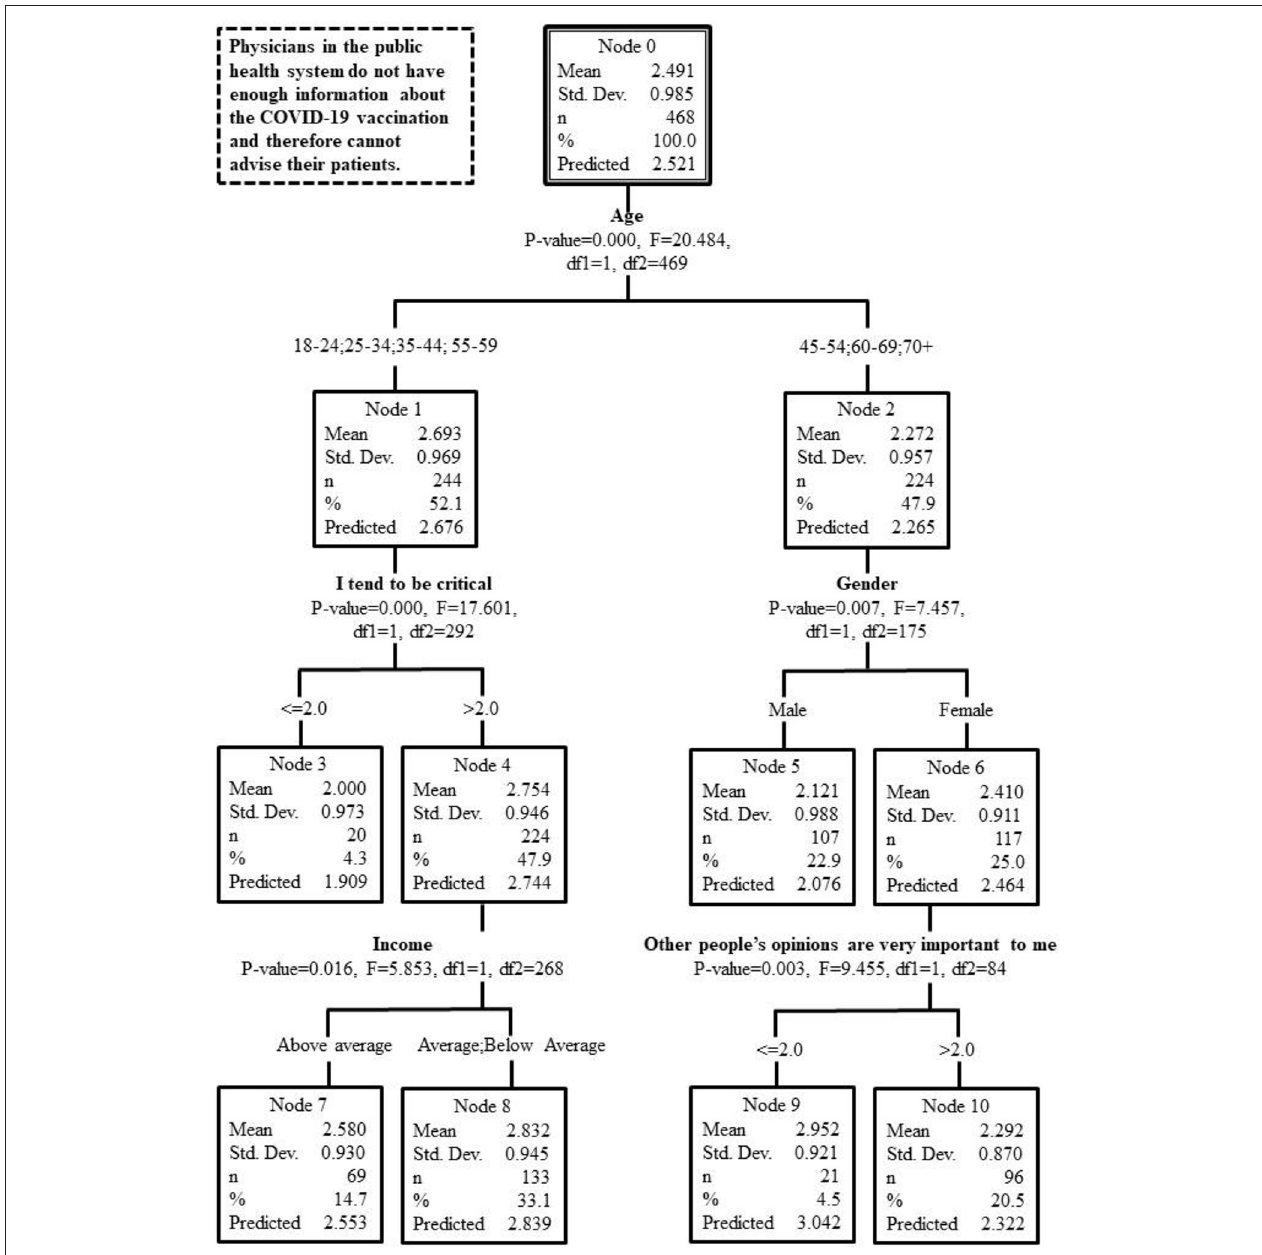
FIGURE 2 | Chart showing results of the CHAID analysis conducted among the